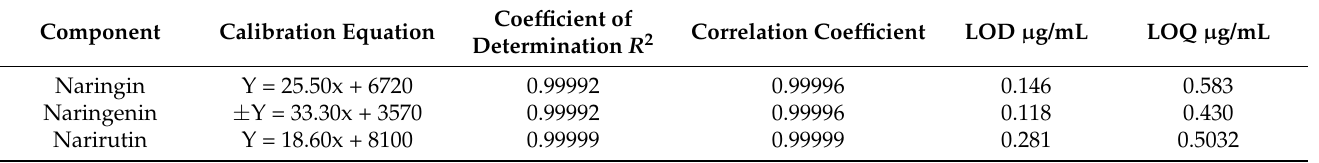
Table 2. The linearities of calibration curves of flavanones.